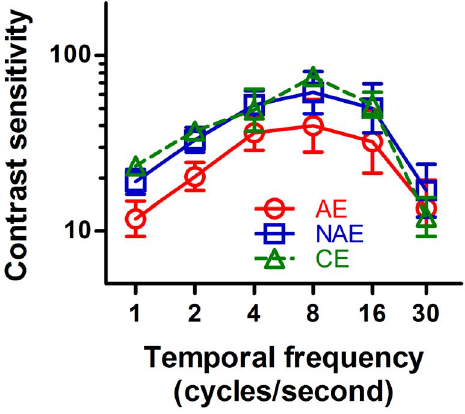
Figure 1. Illustration of stimuli used in this experiment. (a) noise carrier, (b) first-order stimulus, (c) second-order stimulus. All stimuli are presented at screen center, subtended 2.51 u 6 2.51 u .